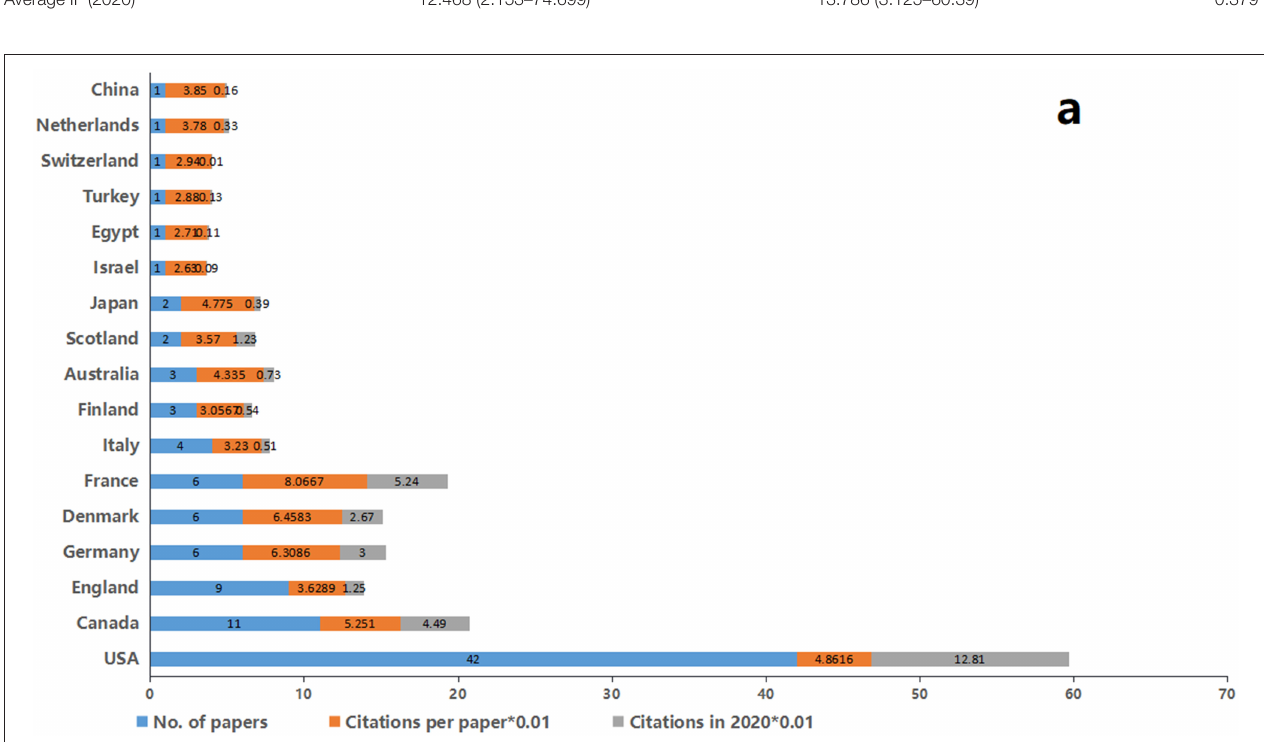
FIGURE 3 | Countries of region of the top 100 most-cited